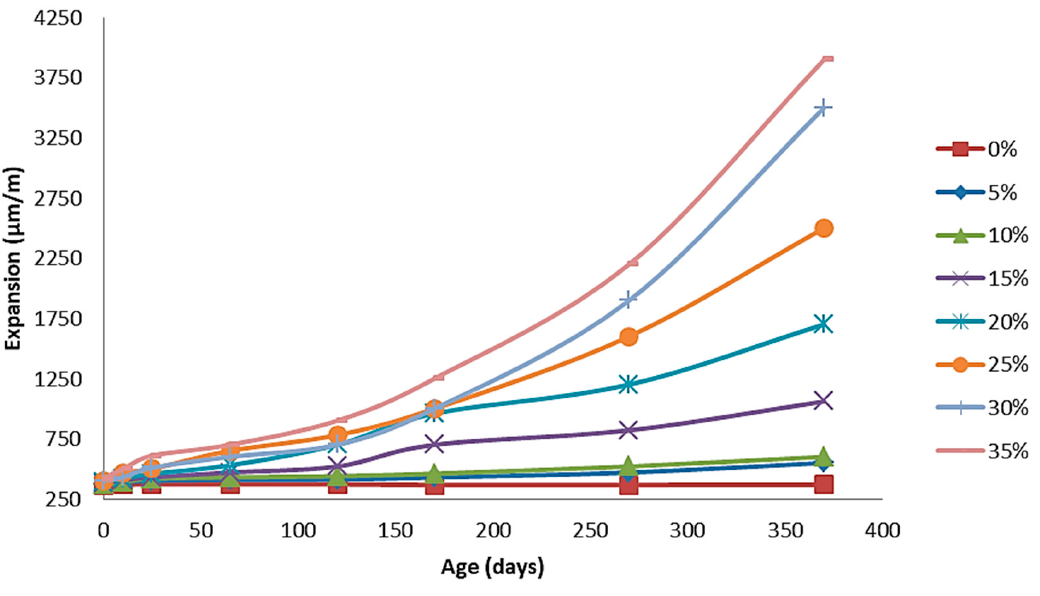
Figure 10. Effect of nano MgO content on expansion performance of cement paste.